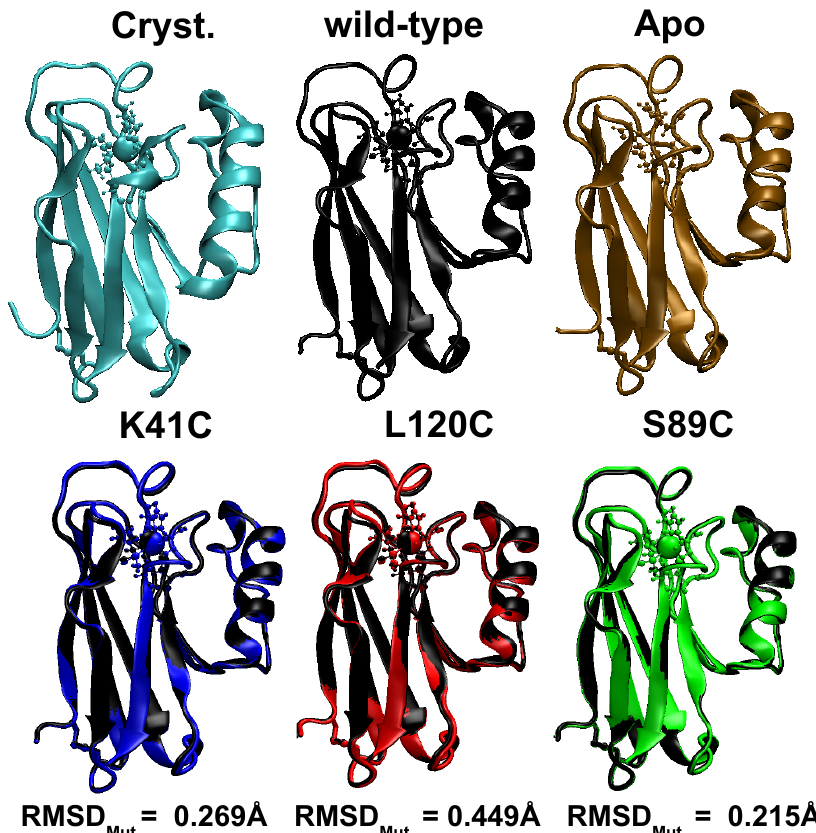
Figure 2. Energetically equilibrated averaged configurations obtained for the unrestrained dynamics in water of the wild-type (black), the Apo (brown), the K41C (blue), the L120C (red) and the S89C (green) proteins. The crystallographic structure [34] is also shown for comparison (cyan). The representation used is the same as in Figure 1. Please note that the three mutant configurations are aligned with the wild-type configuration (black) and superposed to it. The difference is quantified by the RMSD between both average configurations (shown as RMSD Mut